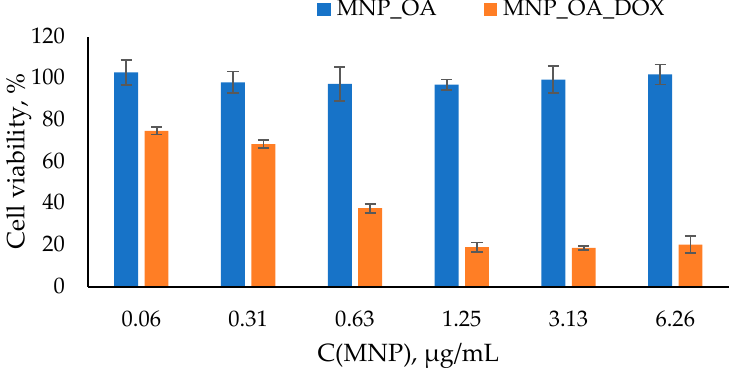
Figure 8. Cell viability assay using MTT compound. A549 cell line was incubated for 48 h with MNPs loaded at various concentrations of MNP_OA and MNP_OA_DOX. Cells treated with PBS buffer were used as a 100% viability control.